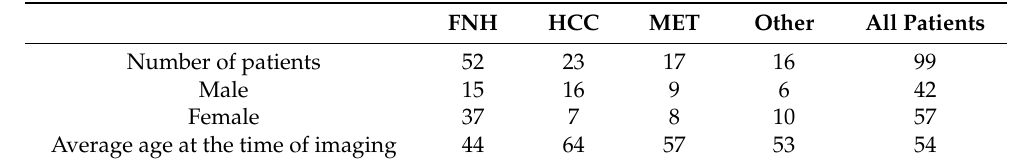
Table 1. Patient demographics and types of lesions analyzed in the study. Some patients were diagnosed with multiple lesion types; therefore, the number of included patients is not equal to the sum of the number of patients diagnosed with different lesion types. FNH HCC MET Other All Patients Number of patients 52 23 17 16 99 Male 15 16 9 6 42 Female 37 7 8 10 57 44 64 57 53